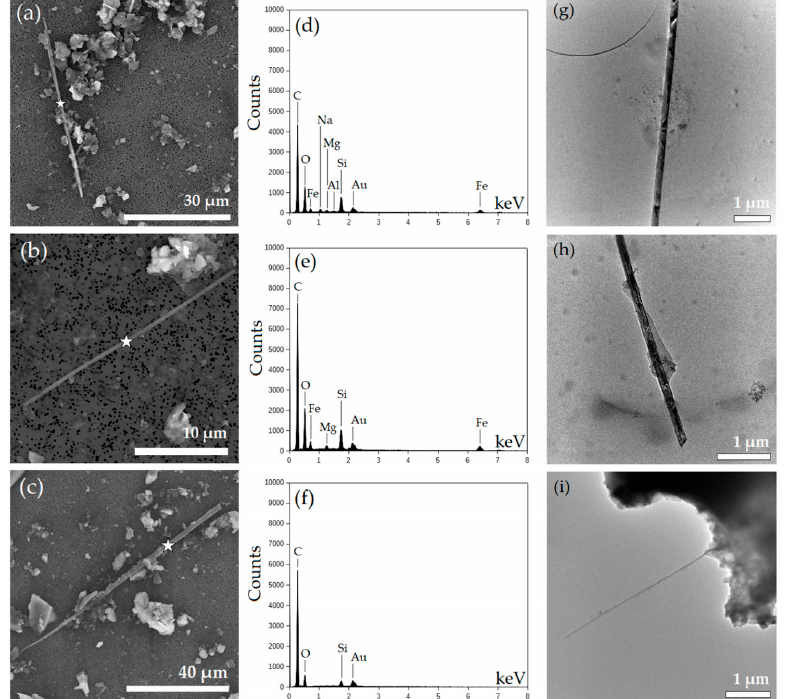
Figure 2. ( a ) FEG-SEM image of a crocidolite fibre; ( b) FEG-SEM image of an amosite fibre; ( c ) FEG-SEM image of a silica-rich relict of chrysotile; ( d ) SEM-EDX spectrum of the fibre shown in ( a ); ( e ) SEM-EDX spectrum of the fibre shown in ( b ); ( f ) SEM-EDX spectrum of the fibre shown in ( c ); ( g ) STEM image of an individual crocidolite fibre with columnar habit; ( h ) STEM images of a prismatic individual crocidolite fibre; ( i ) STEM image of a thin crocidolite fibre. Minerals 2019 , 9 , x FOR PEER REVIEW